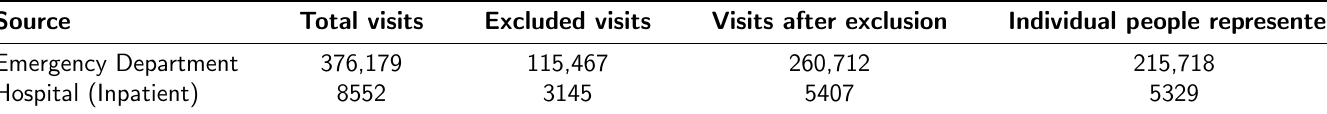
Table 4: Deterministic linkage statistics in the longitudinal sports and recreation injury study – individual persons represented